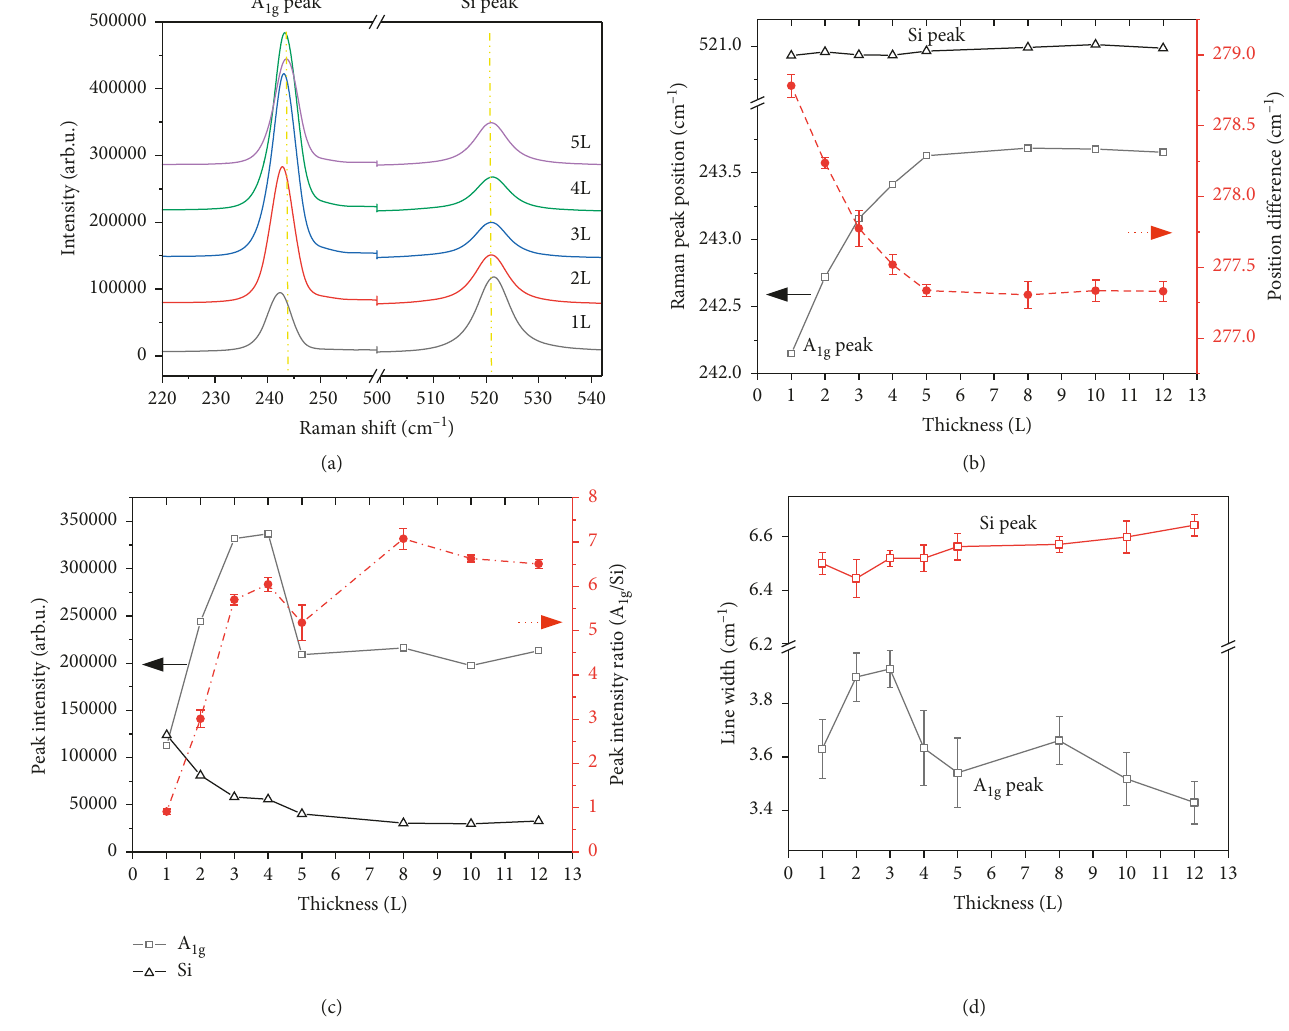
Figure 2: (a) Raman spectra of different layer numbers of MoSe 2 supported by SiO 2 (285 nm)/Si substrate by 633 nm laser. (b) Raman peak position of MoSe 2 ’s A 1g peak and Si peak for different layer numbers (left vertical axis) and their difference (right vertical axis). (c) Raman peak intensity of MoSe 2 ’s A 1g peak and Si peak for different layer numbers (left vertical axis) and their ratio (right vertical axis). (d) Raman peak line width of MoSe 2 ’s A 1g peak and Si